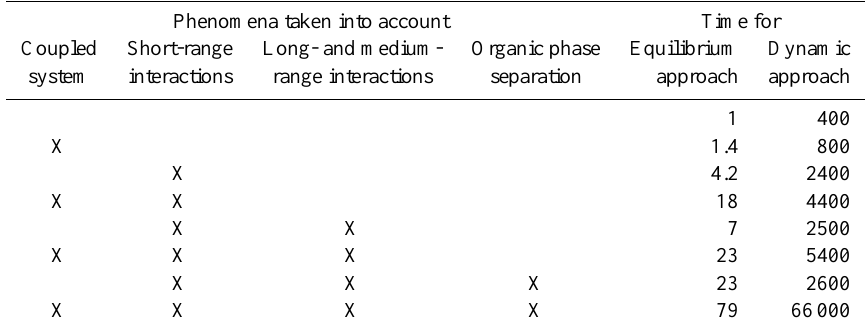
Table 10. Time necessary to solve the biogenic case at RH = 70% (relative to the time necessary to solve the case with an uncoupled system with ideality) for different configurations of the model. Phenomena taken into account Time